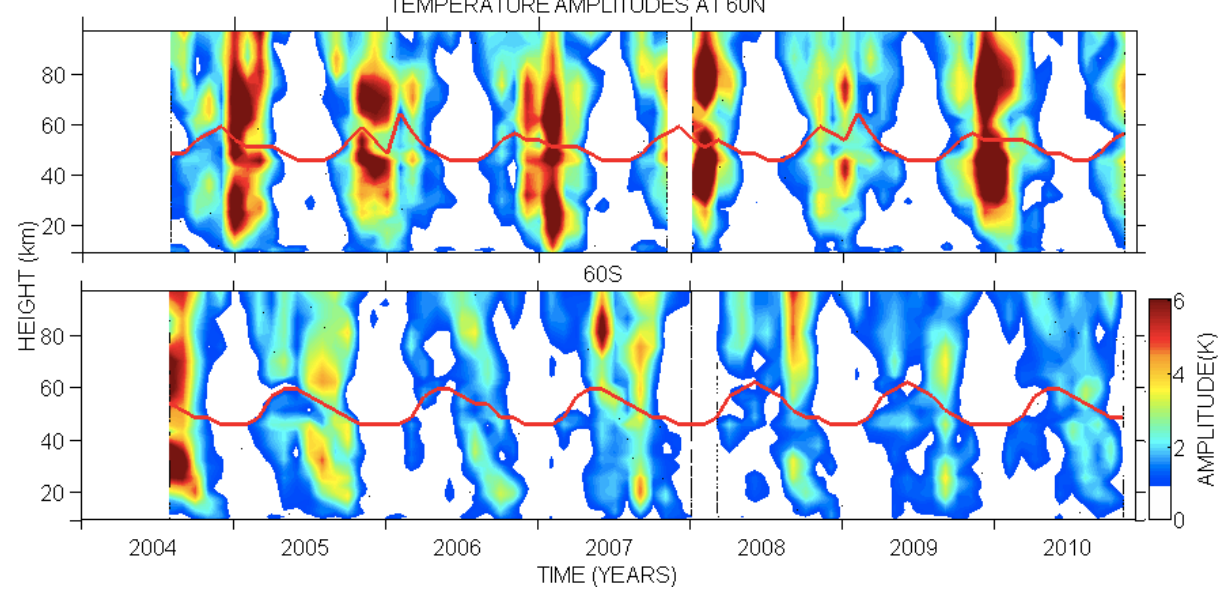
Fig. 4. Time series of monthly-mean temperature amplitudes from 2004 to 2010 for the 16-day wave at a latitude 60 ◦ for both hemispheres. Also plotted is the stratopause height as a red contour